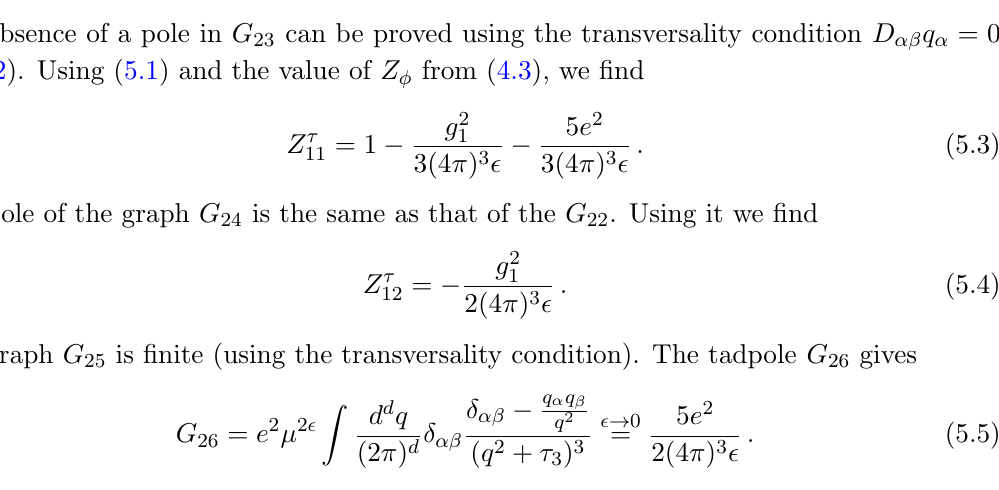
Table 6 . 2-point Green function (cid:0) ( AA ) di(cid:11)erentiated w.r.t.